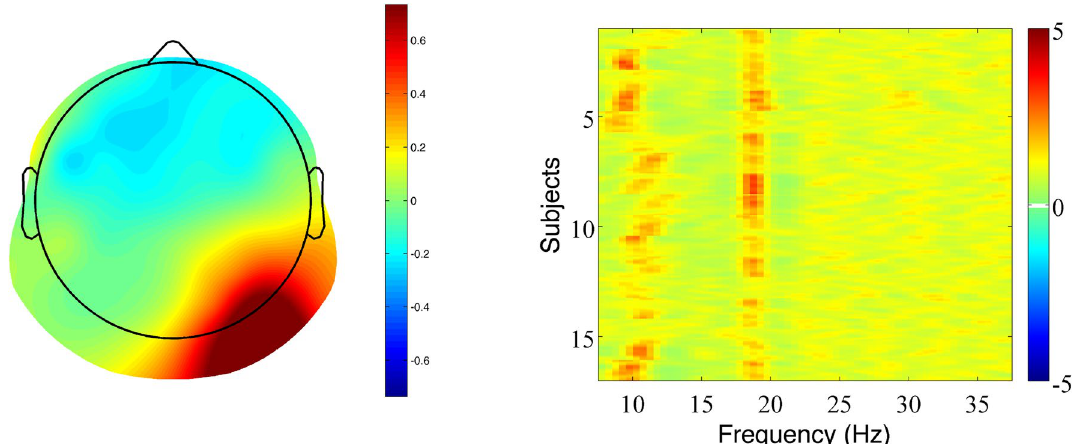
Figure 5. Rhythmic entrainment source separation (RESS) filtered power spectra optimized for 18.75 Hz (Stem). Left panel: Topographic map, averaged across participants. Topoplot color was normalized to [− 1 1] to facilitate visual comparison. Right panel: Spectral density (SNR) between 5 and 37 Hz for each participant (rows). The vertical red line at 18.75 Hz corresponds to the entrainment at the stimulation frequency. The left panel of this figure was created using FieldTrip (https:// www. field tript oolbox. org/) 72 , the right panel